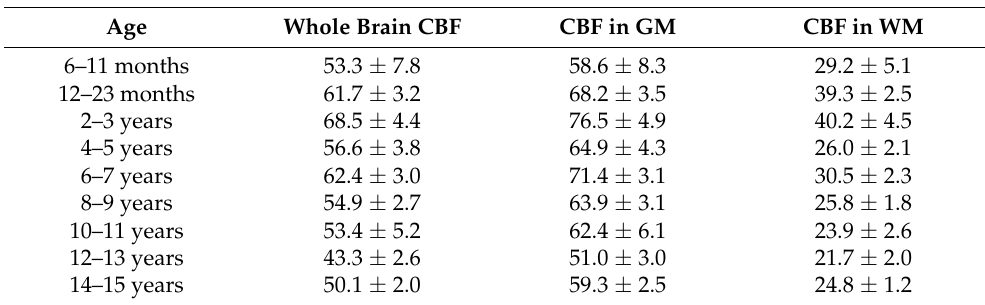
Table 3. Absolute CBF values (mL/100 g/min) for each age group for the whole brain, gray matter (GM) and white matter (WM)